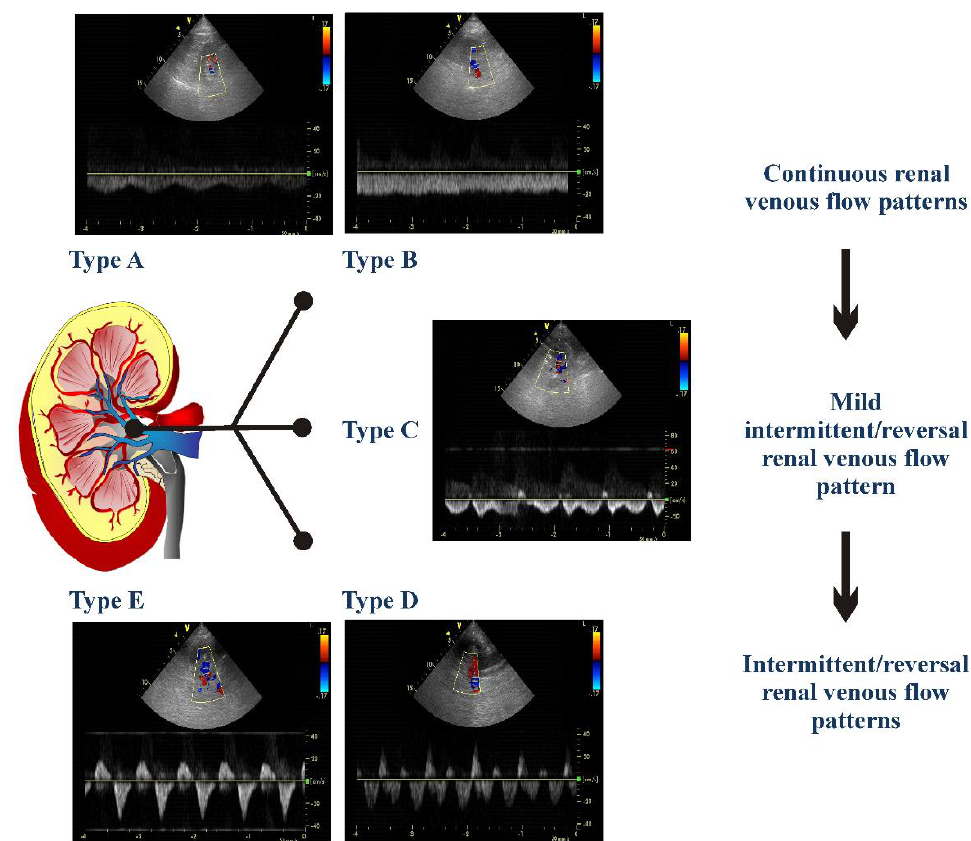
Figure 1. The different detectable renal venous patterns are presented. Pattern A was a flow pattern with normal velocity decrease of presystolic flow and biphasic pattern without interruption of telediastolic flow; Pattern B a continuous flow pattern with minimal fluctuations; Pattern C a pattern showing a short telediastolic interruption of forward flow or a short telediastolic reversal flow; Pattern D a flow characterized by a biphasic interruption or reversal flow during the same cardiac cycle; Pattern E a flow characterized by one forward and one reversal wave flow, i.e., monophasic intermittent pattern.